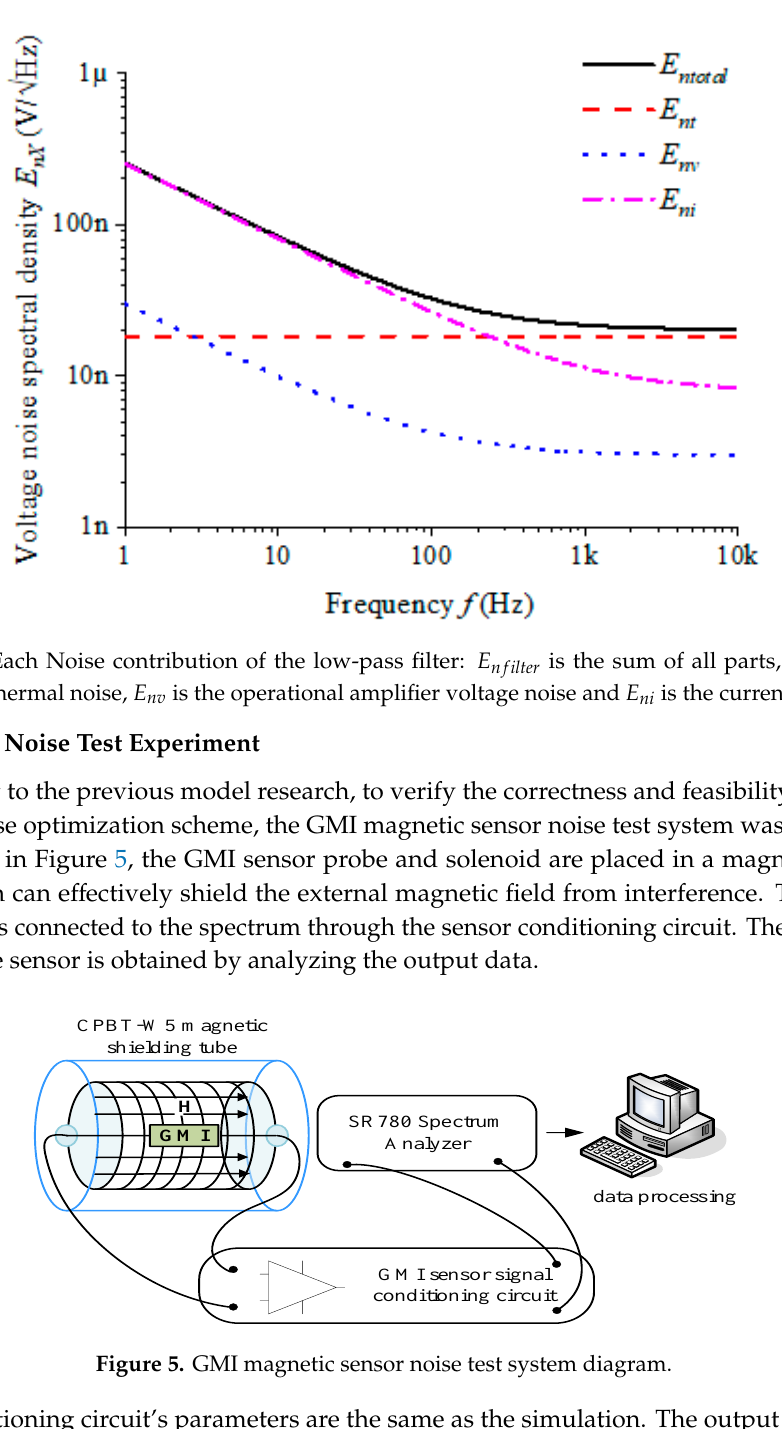
Figure 4. Each Noise contribution of the low-pass filter